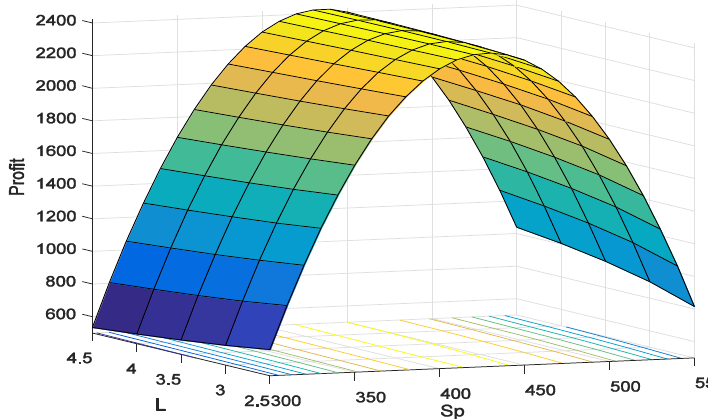
Figure 7. Profit function of Example 2 with regard to s p and L .